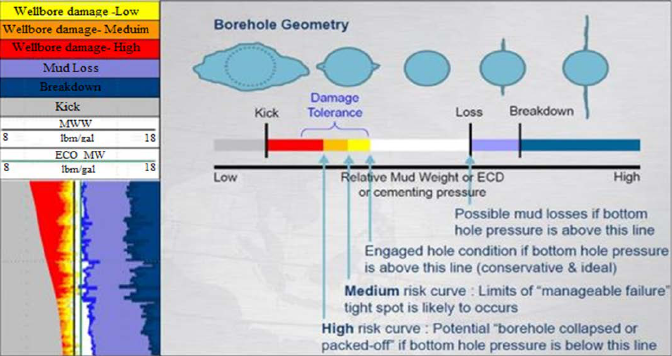
Figure 2. Typical flowchart of adequate mud density identification.